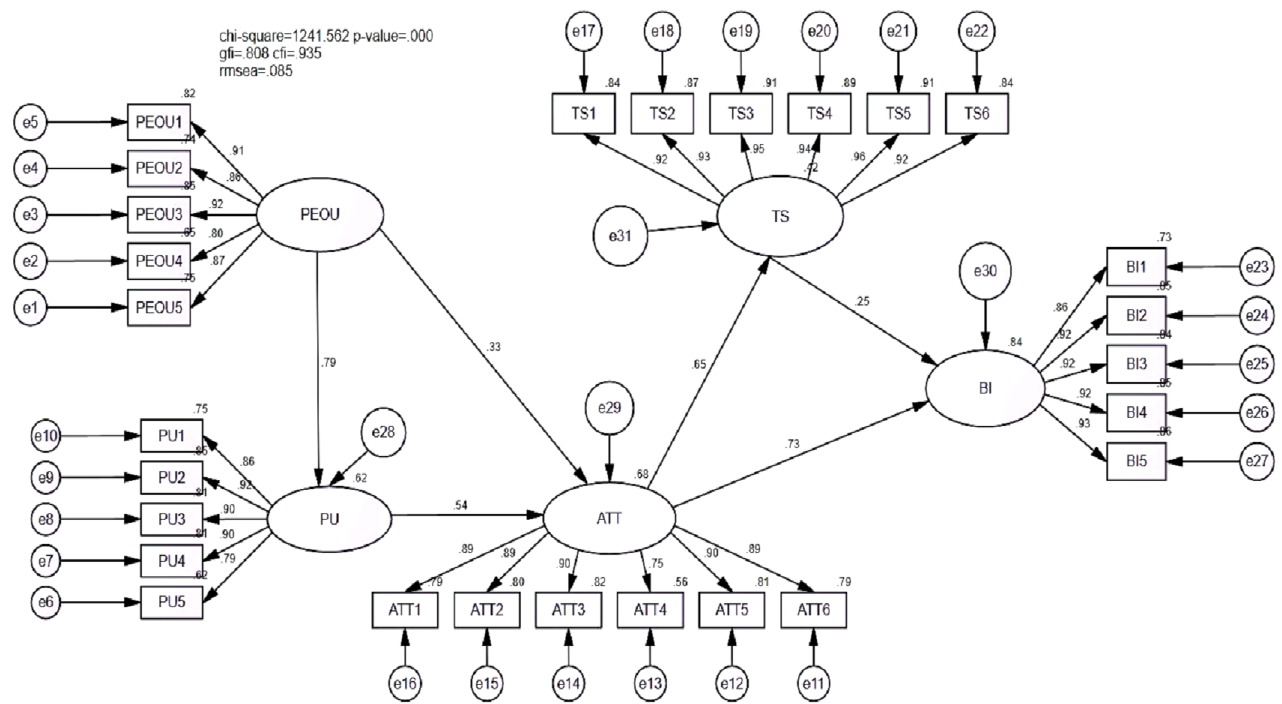
Figure 3. Overall model analysis. Source: summarized by this research. Table 10 Discriminant validity between constructs.